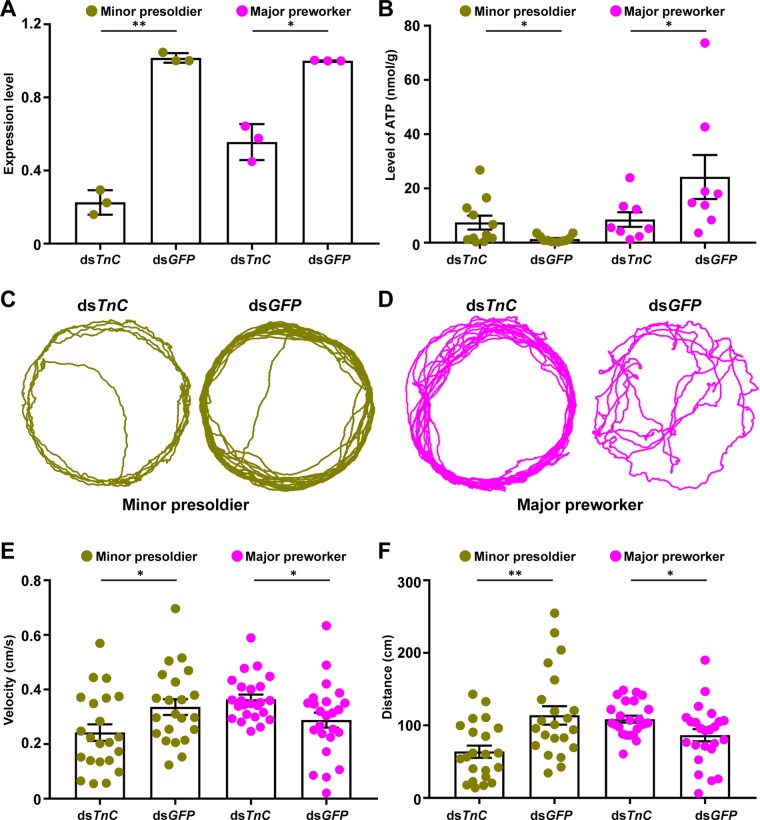
Mobility of minor presoldiers and major preworkers can be affected by the expression of TnC. (A) The expression level of TnC after RNAi treatment. (B) The ATP level after knockdown of TnC in minor presoldiers and major preworkers. Representative images of the motion trail after knockdown of TnC in (C) minor presoldiers and (D) major preworkers. (E) The velocities and (F) distances after knockdown of TnC in minor presoldiers and major preworkers. Data are shown as the mean ± S.E.M. *0.05 > P > 0.01; **0.01 > P > 0.001.